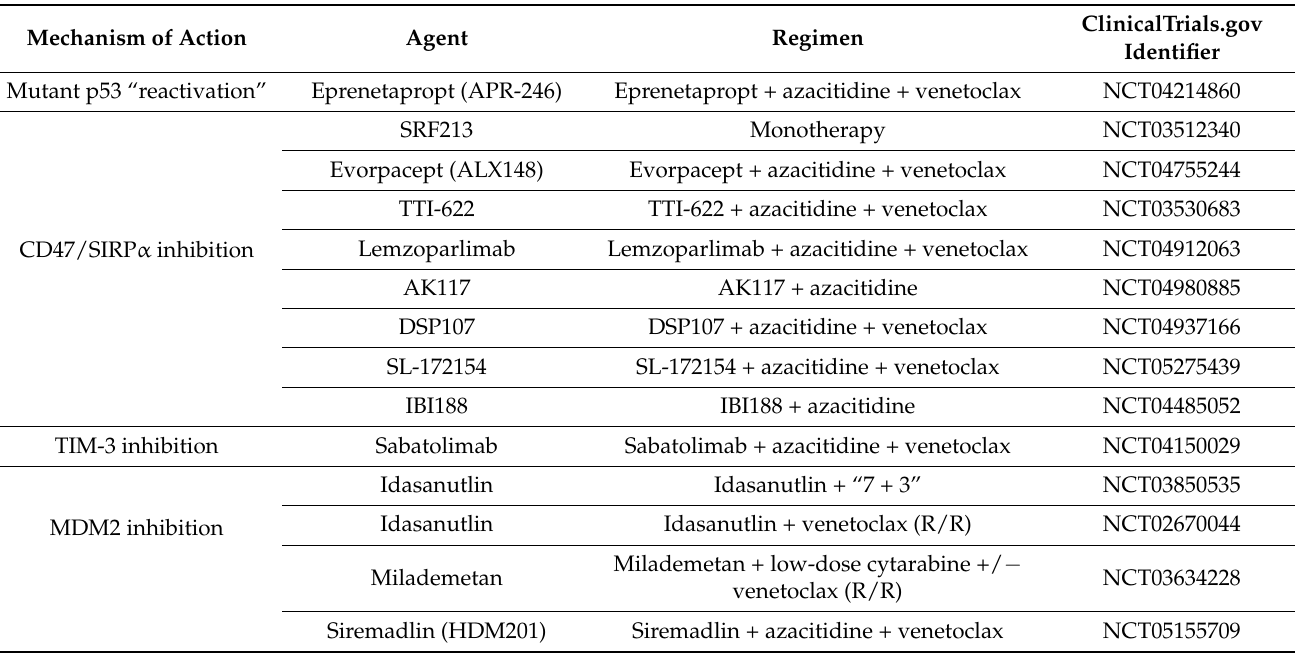
Table 3. Ongoing frontline clinical trials including TP53 -mutated AML patients without clinical